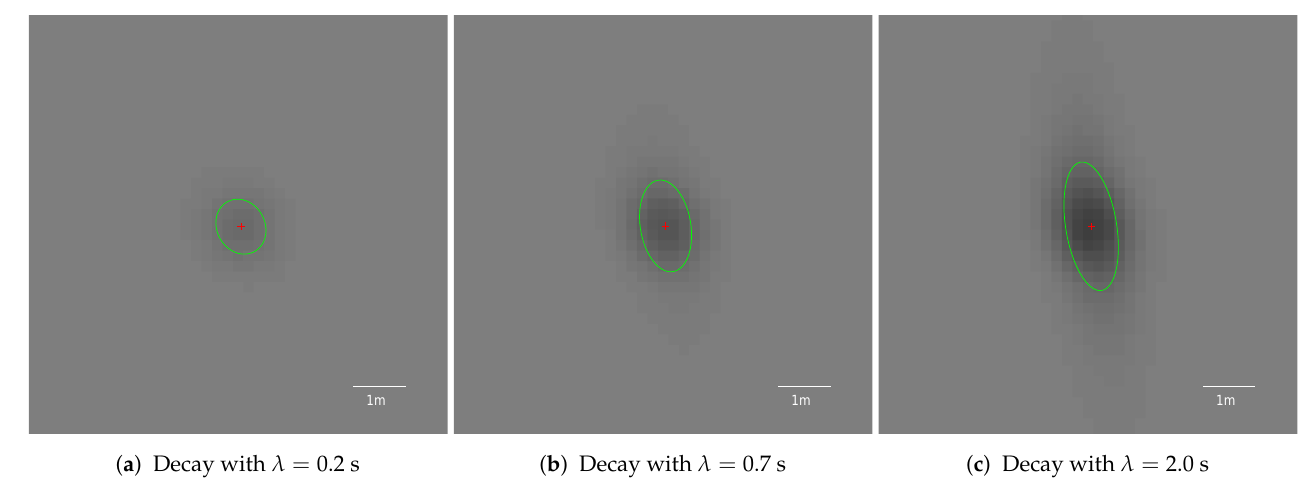
Figure 15. Averaged occupancy grid representations of the pole using different decay mean lifetimes with a 2D Gaussian sensor model. Each snapshot presents the pole located 10 m from the left side of the vehicle, captured when the host was 10 m away